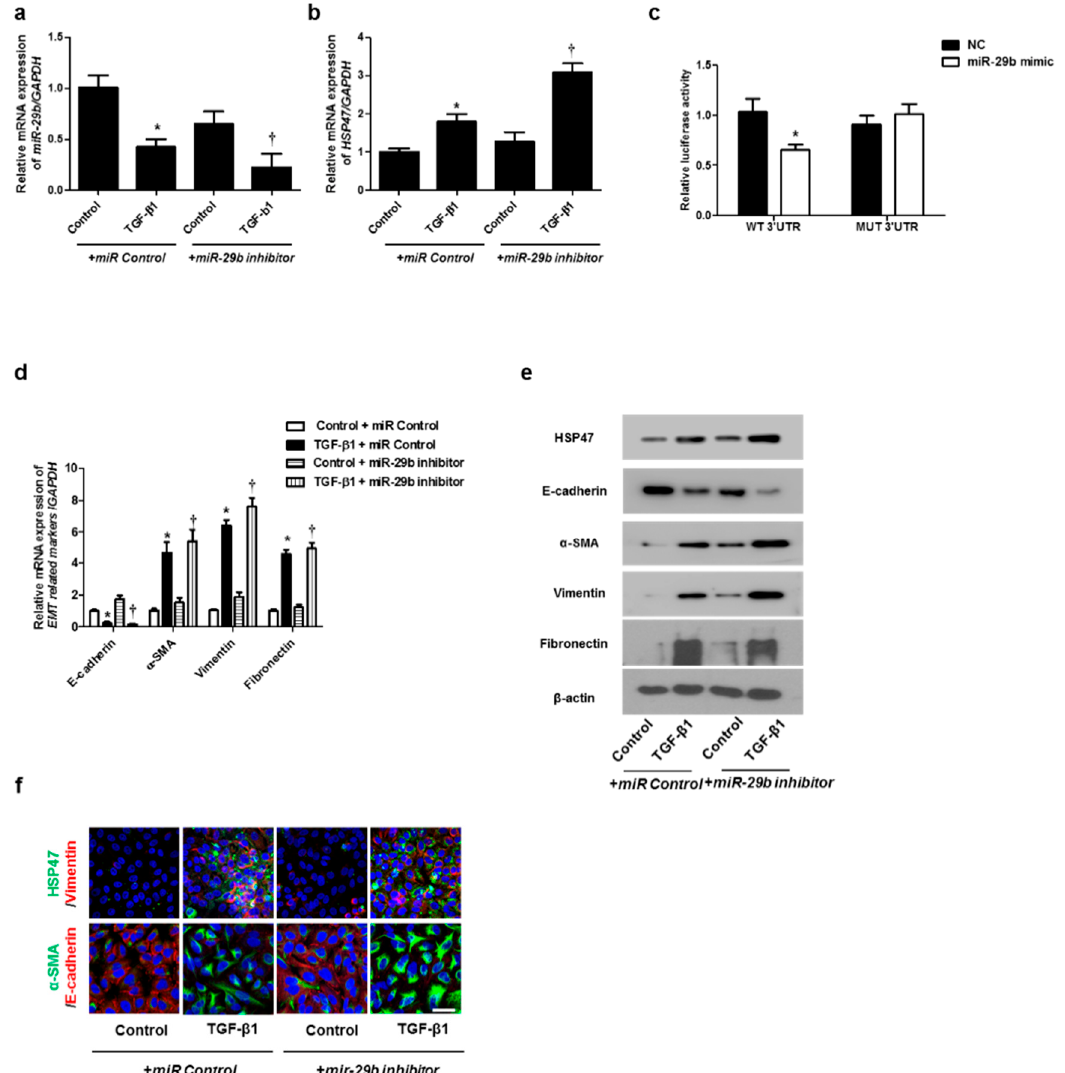
Figure 3. Inhibition of miR-29b expression induced mRNA and protein expression levels of TGF- β 1-induced EMT markers in A549 cells. A549 cells were stimulated with TGF- β 1 (5 ng/mL) with miR control or a miR-29b inhibitor . ( a , b ) The mRNA expression levels of miR-29b and HSP47 were analyzed using qPCR. ( c ) HSP47 luciferase activity was measured by luciferase assay. ( d ) The mRNA levels of EMT-related markers were measured using qPCR. ( e ) Protein expression levels of HSP47, E-cadherin, α -SMA, vimentin and fibronectin were determined using Western blotting. ( f ) The cells were treated with TGF- β 1 for 72 h after transfection with miR-29b inhibitor , and then assessed for HSP47 (1st line, green), vimentin (1st line, red), α -SMA (2nd, green), and E-cadherin (2nd, red) expression/localization using immunofluorescence. Nuclei were stained with DAPI (blue). Scale bar = 20 μ m. Values are expressed as mean ± SEM of three independent samples. * p < 0.05 vs. control + miR Control ; † p < 0.05, vs. TGF- β 1 + miR Control .